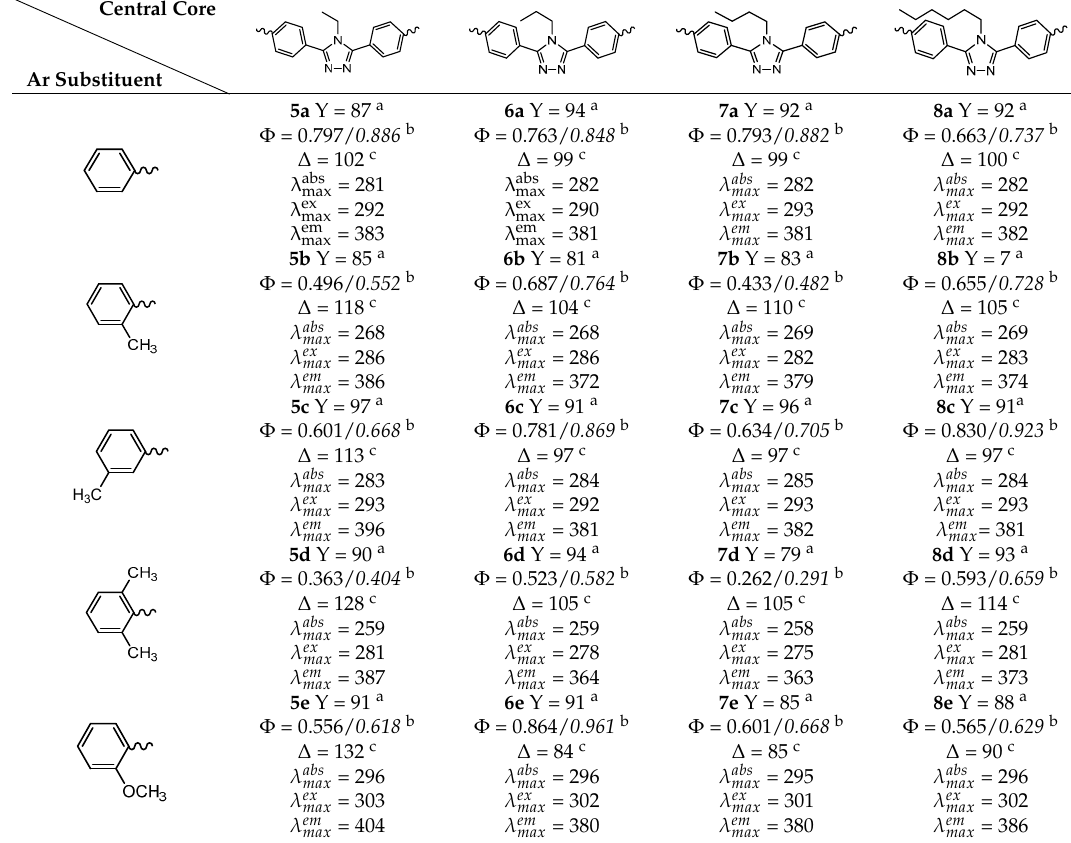
Table 4. 4-Alkyl-3,5-bis(4-arylphenyl)-4 H -1,2,4-triazoles 5a–n, 6a–n, 7a–n, 8a–n prepared in Suzuki cross-coupling reaction.